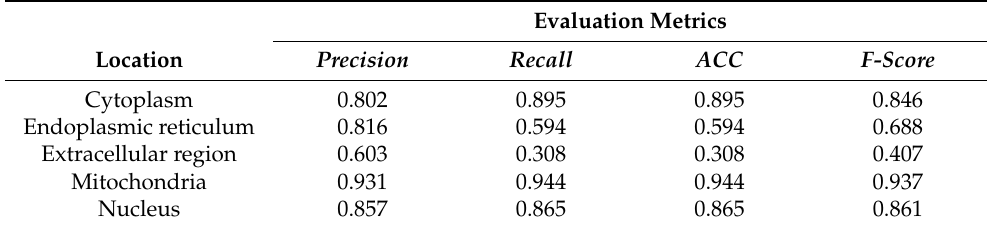
Table 2. The performance of DeepmRNALoc on the independent validation set (in Dataset 1).